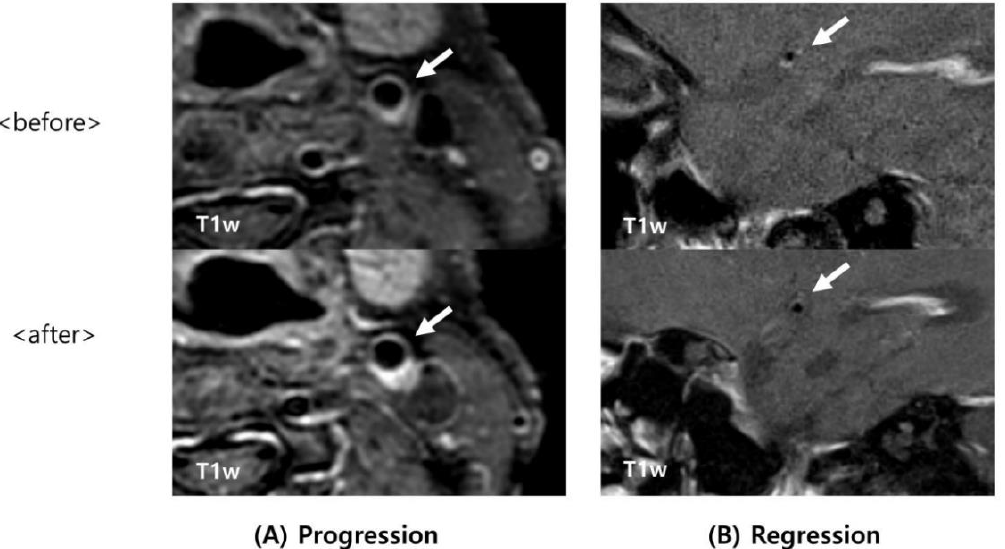
Figure 2. Examples of progression and regression of intraplaque hemorrhage on HR-MRI. ( A , B ) Atherosclerotic plaque with intraplaque hemorrhage (arrow). ( A ) Upper panel: initial T1-weighted (T1w) HR-MR imaging in the left CCA shows an eccentric plaque with intraplaque hemorrhage (IPH); lower panel: follow-up T1w HR-MR imaging shows significant atherosclerotic lesion with high signal intensity in the same area that indicates progression of IPH more than the initial imaging does. ( B ): Upper panel: initial T1w HR-MR imaging shows an eccentric lesion with IPH in the MCA. Lower panel: follow-up T1w HR-MR imaging reveals the MCA without IPH. HR-MRI = high-resolution magnetic resonance imaging; CCA = common carotid artery; MCA = middle cerebral artery.